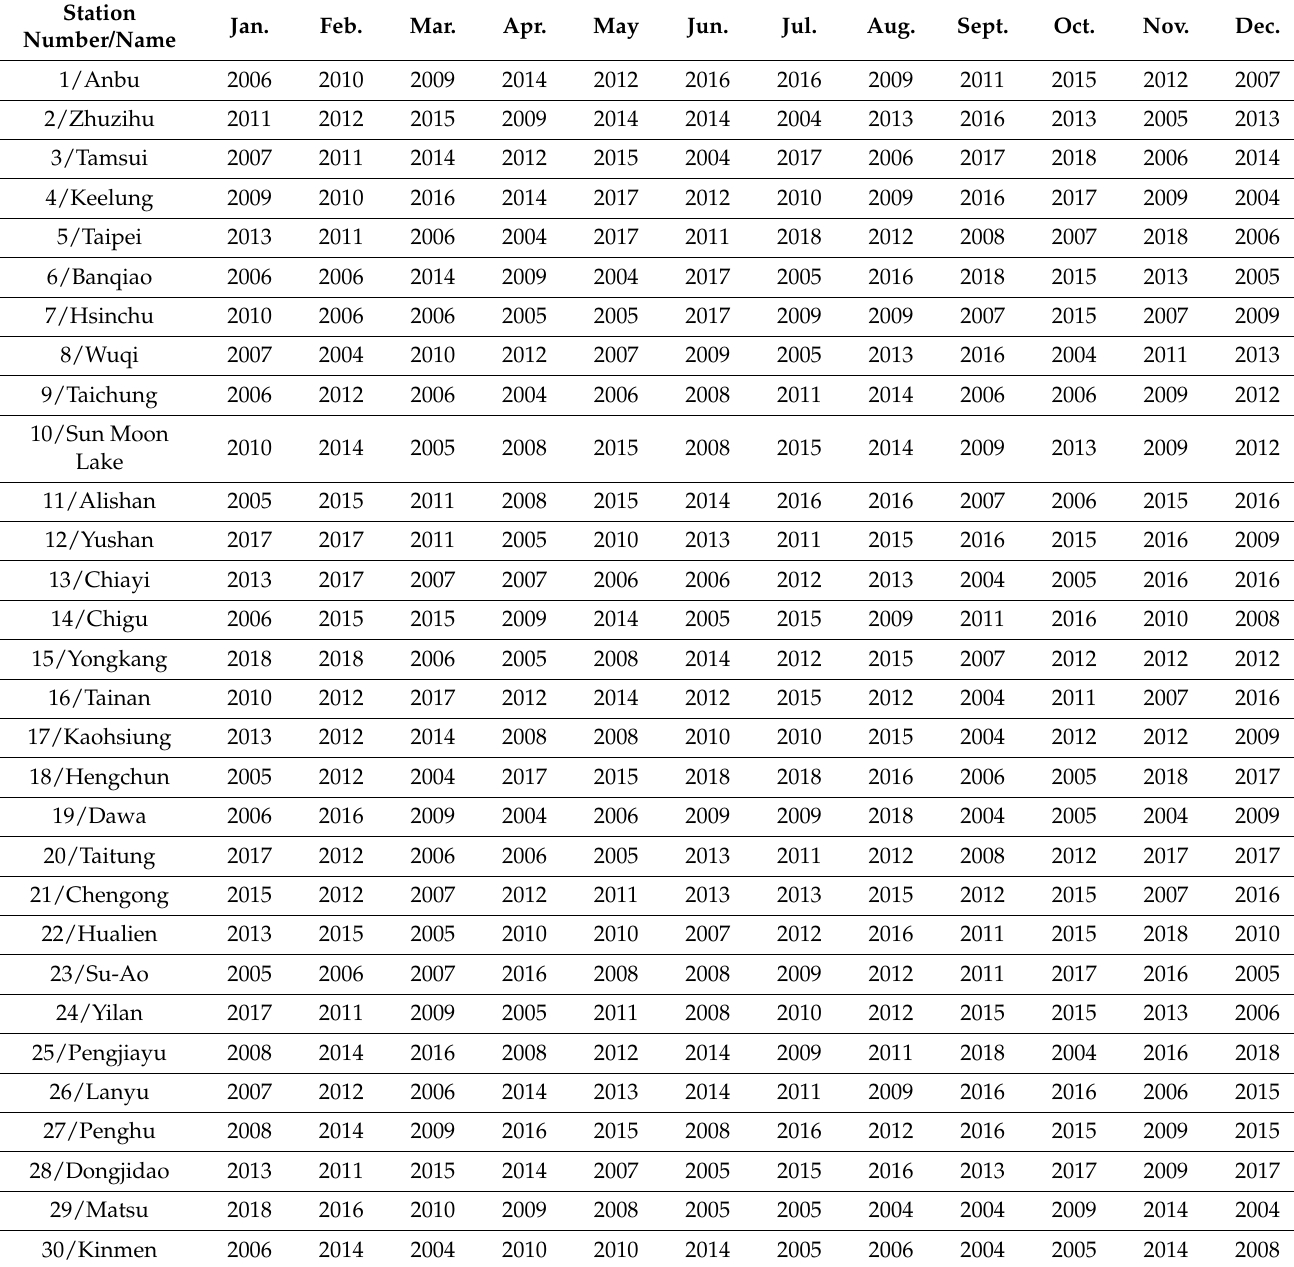
Table 4. List of TMMs for the 30 weather stations for this